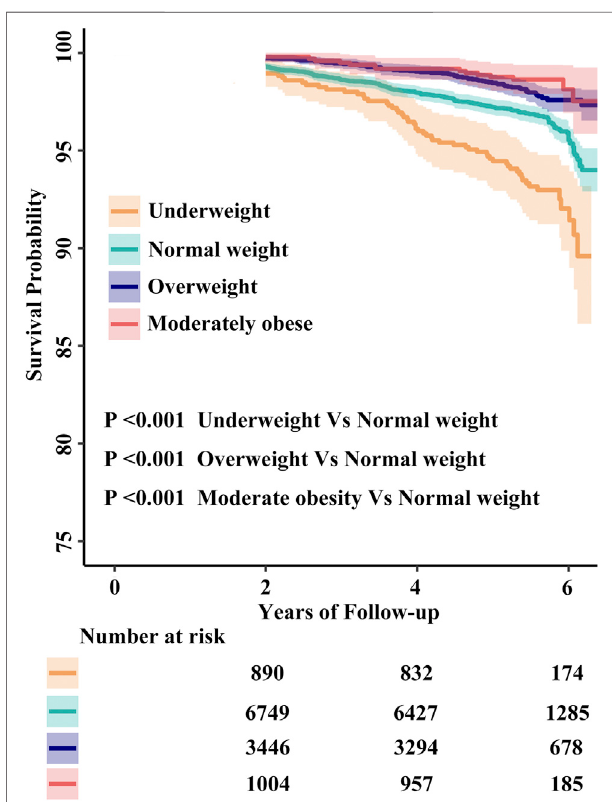
FIGURE 3 | The cumulative hazards of all-cause mortality according to quartiles of body mass index. Abbreviations: BMI, body mass index.